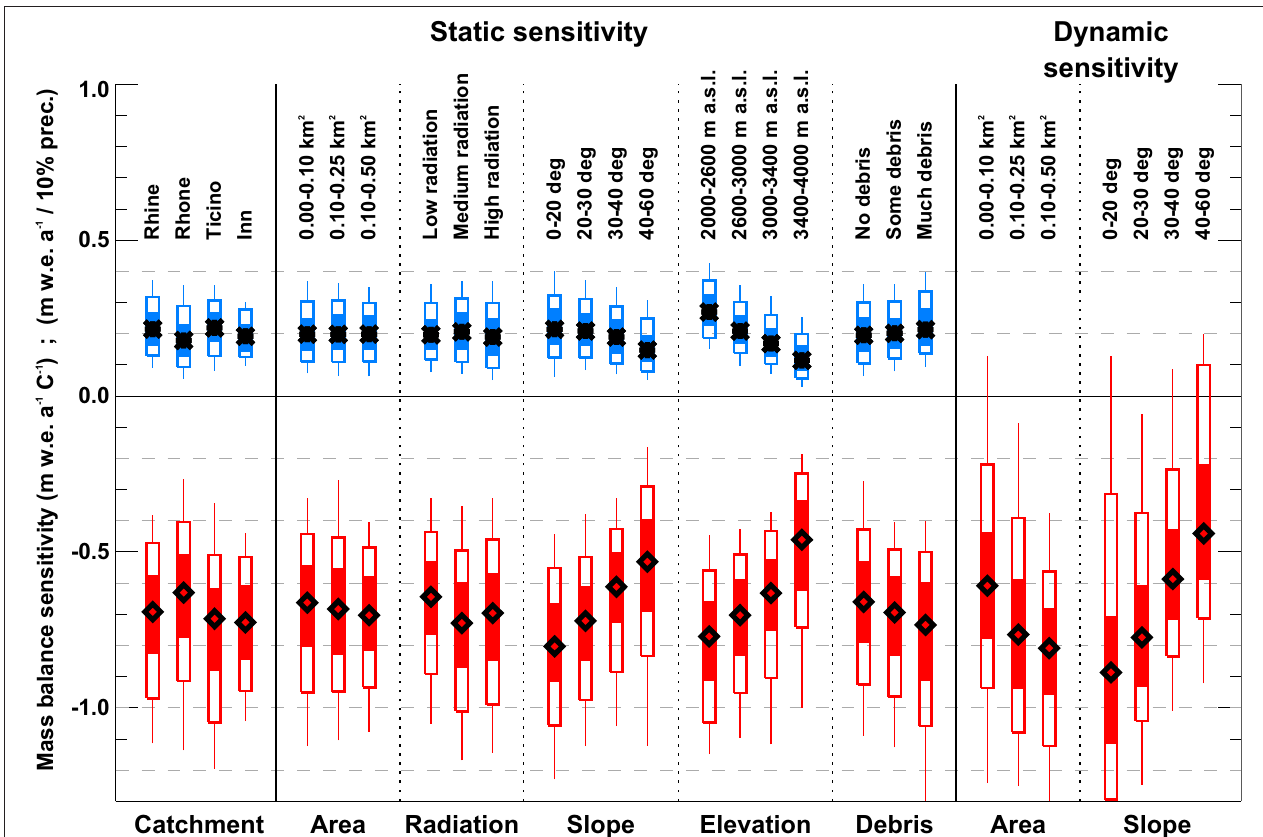
FIGURE 6 | Calculated static and dynamic sensitivities (see text for details) of very small glaciers to temperature ( + 1 ◦ C, red) and precipitation change ( + 10%, blue). Glacier-specific sensitivities are shown for (i) the large-scale catchments, classes of (ii) area, (iii) radiation, (iv) slope, (v) elevation, and (vi) debris coverage. Diamonds show the median, shaded (light) bars the 50 (80)% quantile range of all glaciers, and lines span the 2.5 to the 97.5%